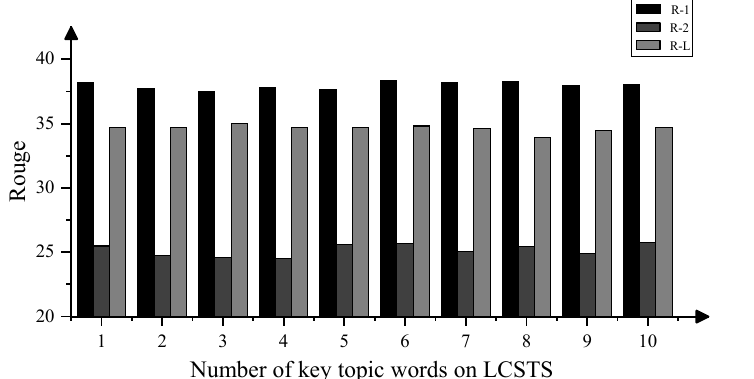
Figure 6. Correlation between summaries quality and the number of topic terms in the LCSTS dataset (number of topics is 18).